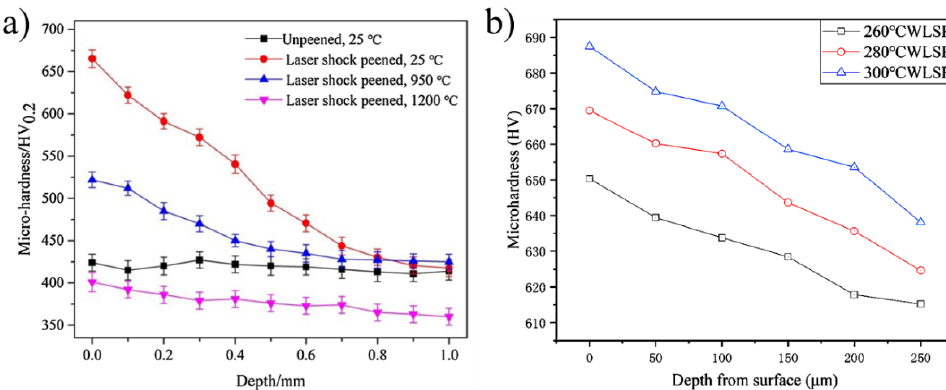
Figure 3. Microhardness distributions in works by ( a ) Geng et al. and ( b ) Tang et al. Reprinted from [45,48] with permission from Elsevier and Springer Nature respectively.